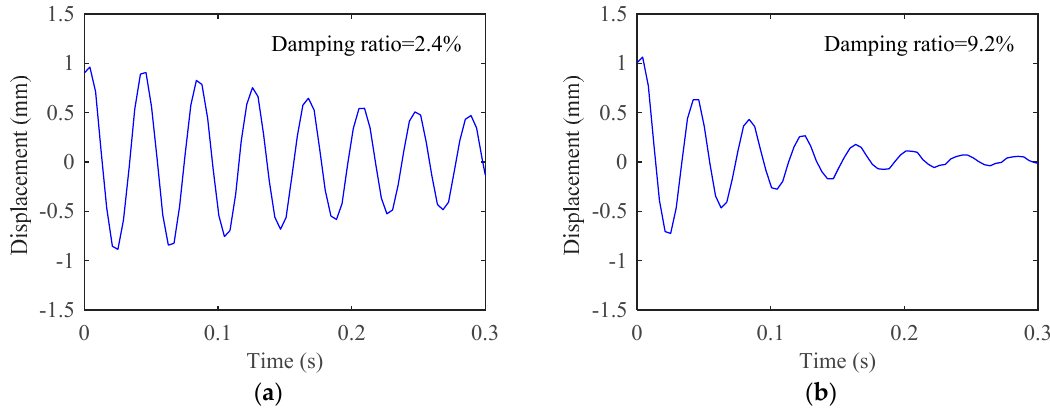
Figure 5. Free vibration of ECTMD. ( a ) Without copper plate; ( b ) With copper plate.